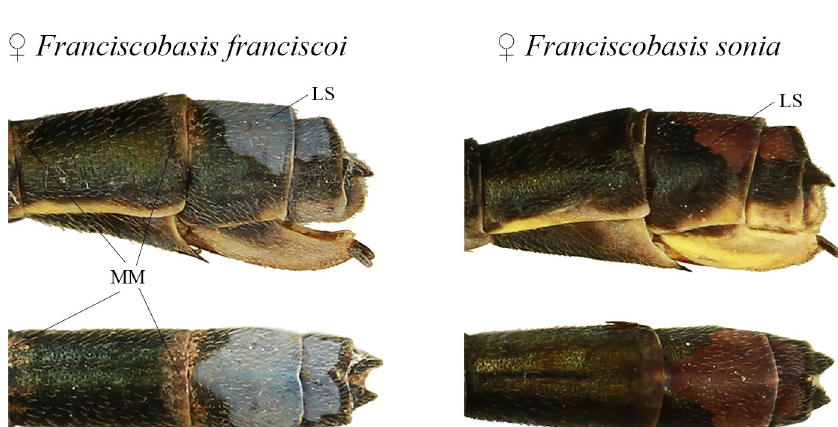
Fig 5. Coloration similarities between Franciscobasis sonia and F . franciscoi . LS: large dorsal spot; MM: Mud marks.